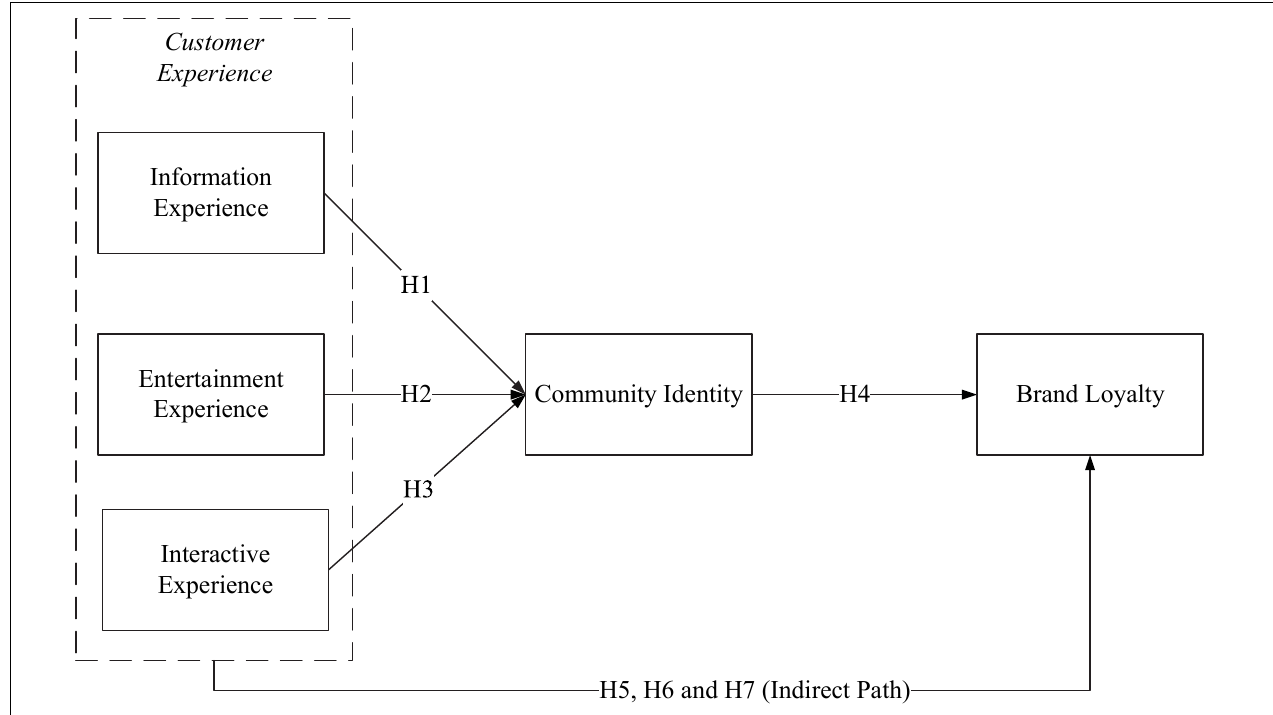
FIGURE 1 | Theoretical